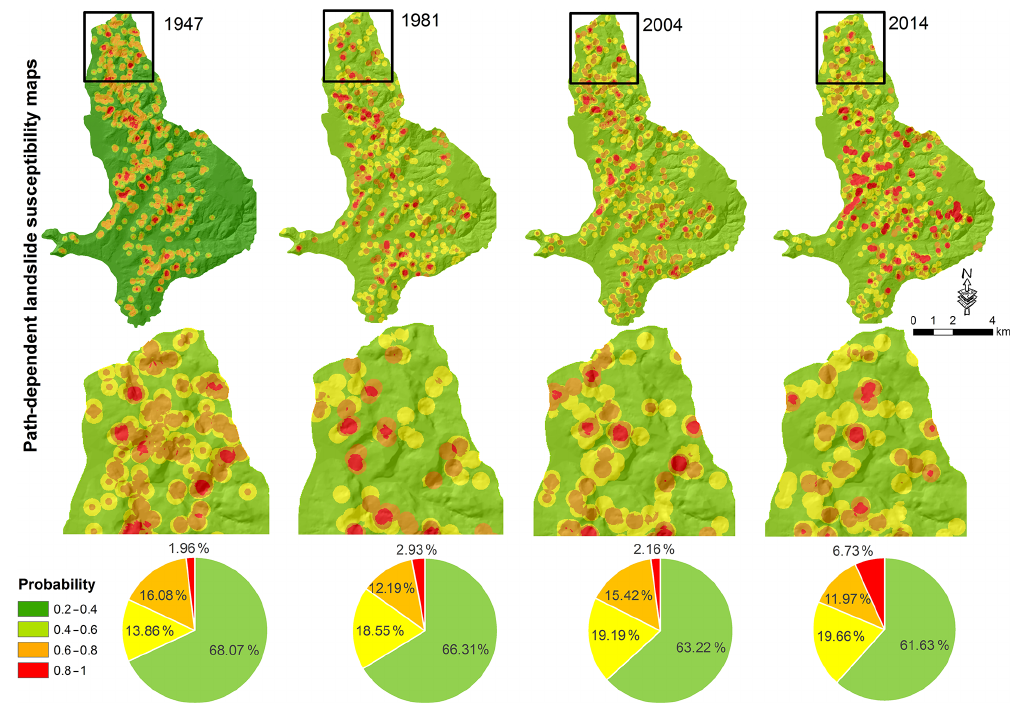
Figure 10. Examples of four dynamic path-dependent landslide susceptibility maps in the years 1947, 1981, 2004 and 2014. Zoomed maps show the places where there are large changes in susceptibility over